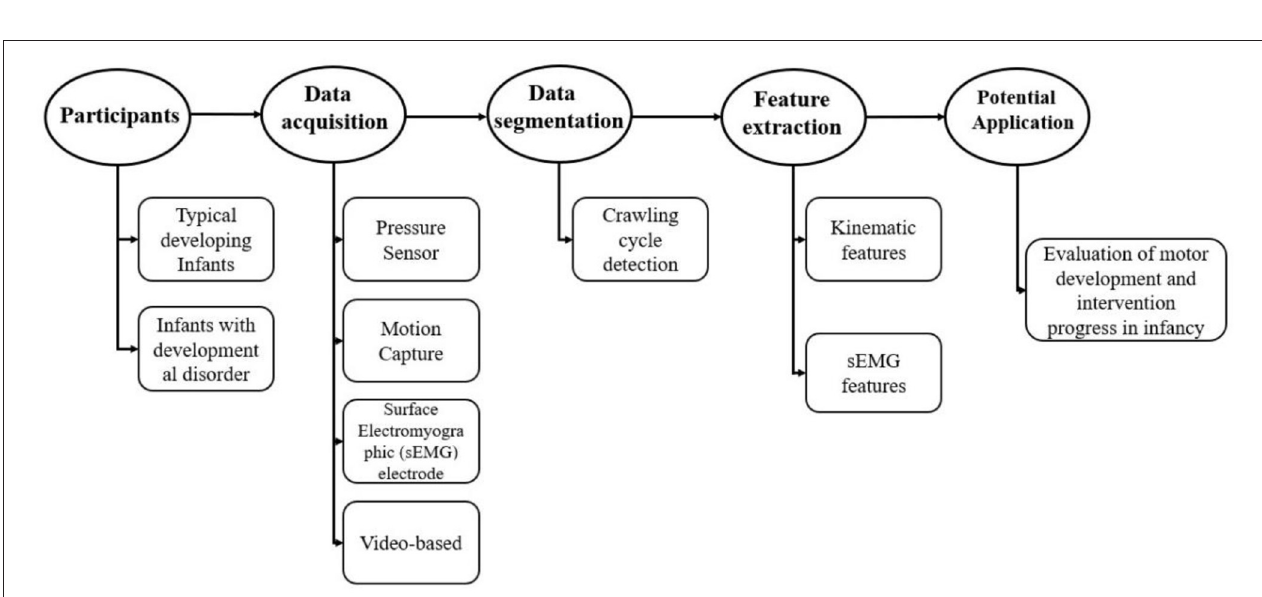
FIGURE 2 | Brief research protocol usually used in the study of infant crawling